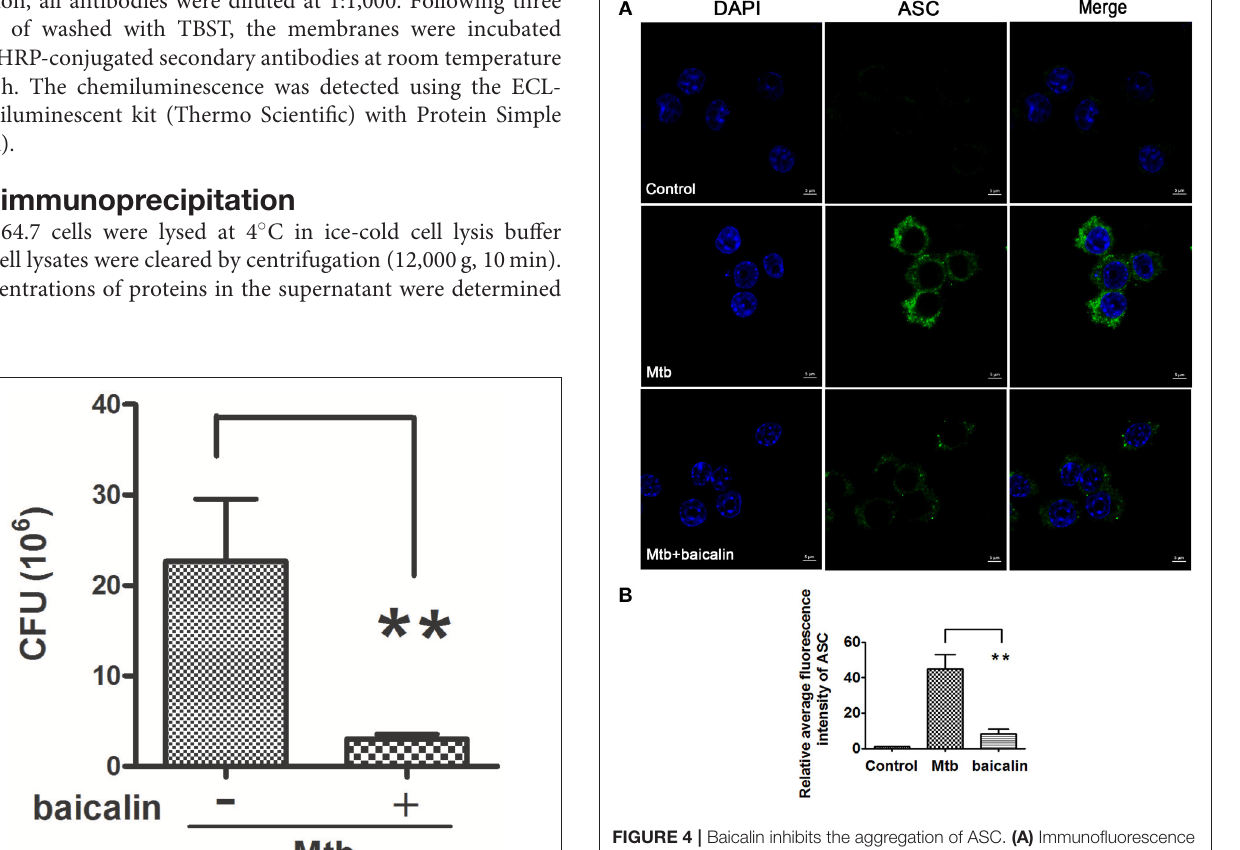
FIGURE 4 | Baicalin inhibits the aggregation of ASC. (A) Immunofluorescence assay was performed and rabbit anti-ASC (green) and DAPI (blue) were used for immunostaining. Images were obtained with laser scanning confocal microscopy. (B) Quantification of the confocal images about ASC. The confocal images about ASC were quantified with ZEN 2011 Blue Version. Data are shown with means ± SD . * p <